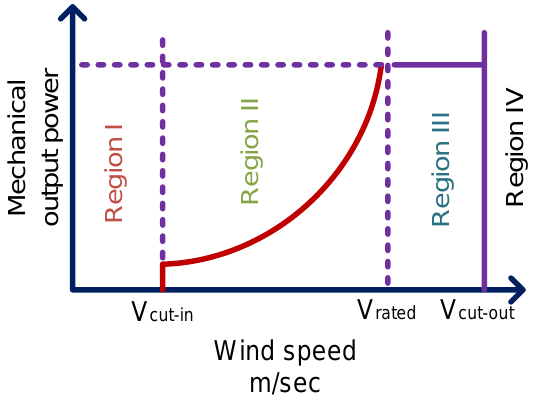
Figure 1. Operating regions of wind